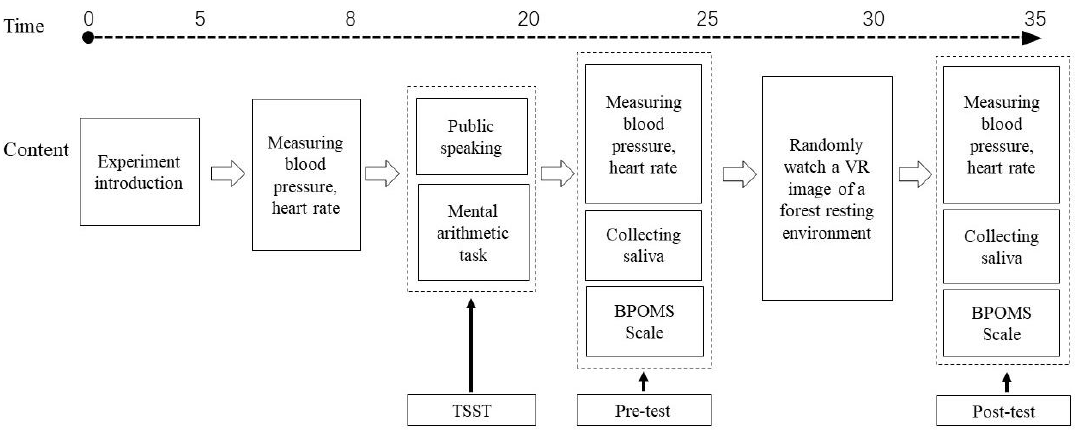
Figure 2. Experimental process chart. VR-virtual reality; TSST-Trier Social Stress Test; BPOMS-Brief Profile of Mood States.